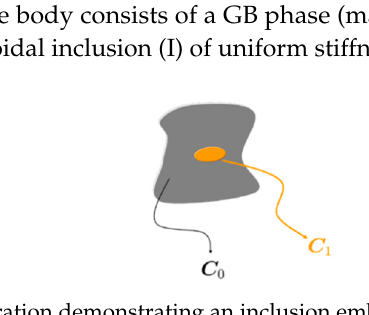
Figure 2. Illustration demonstrating an inclusion embedded in an infinite body.